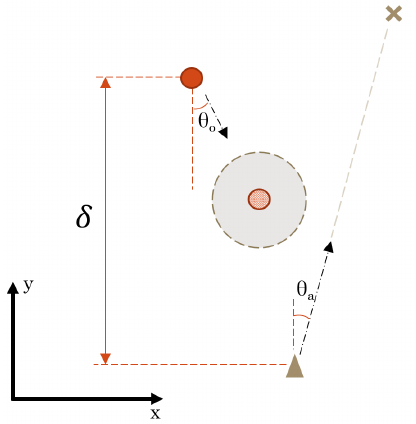
Figure 5. Point-of-conflict of a single diagonal movement